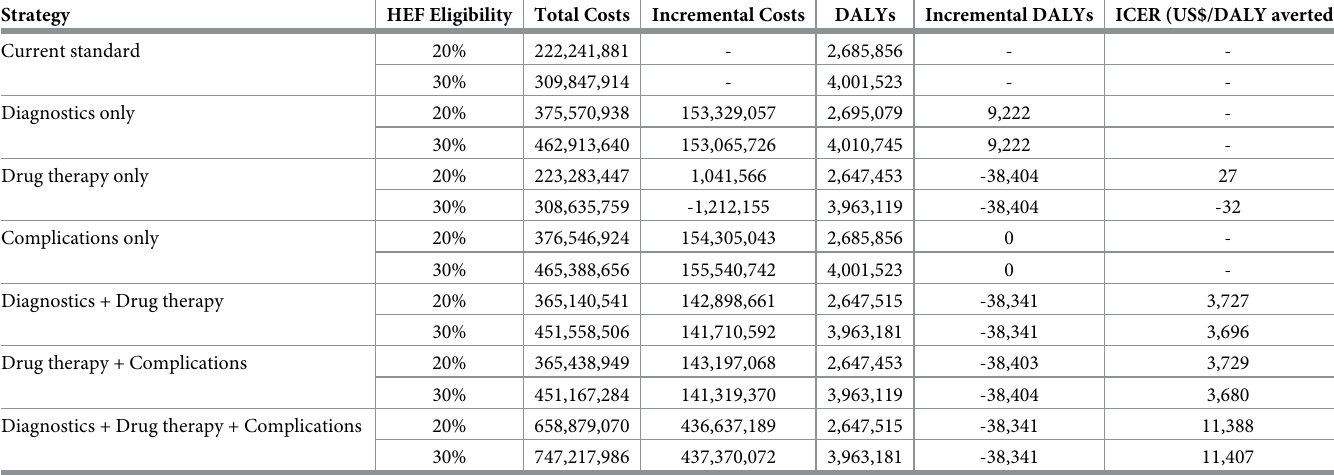
Table 3. Incremental costs and health impact by strategy and HEF coverage